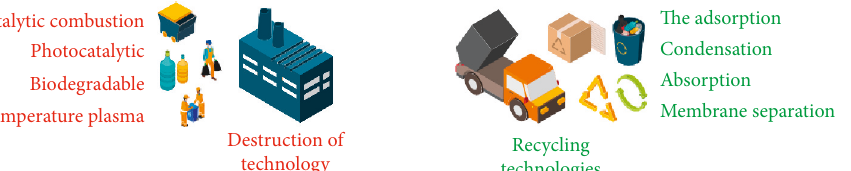
Figure 1: Common VOCs treatment technology.